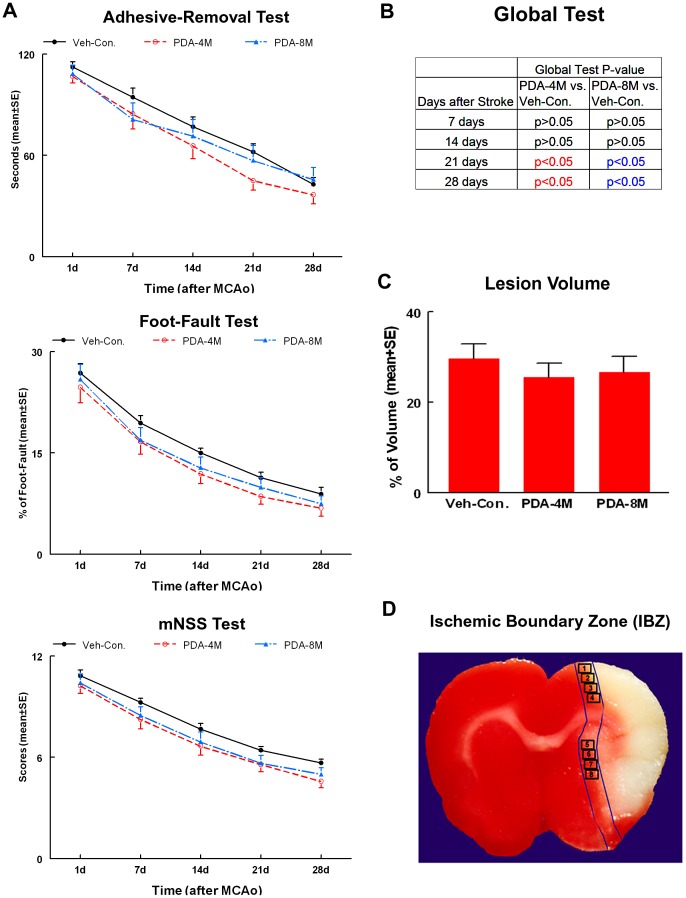
Neurological outcome and lesion volume in older rats.Panel A shows adhesive-removal, foot-fault and mNSS tests after stroke in the 3 older rats experimental groups (vehicle-control, 4×106 and 8×106 PDA-001 treatment groups). Panel B shows the global test analysis to detect the differences in functional recovery among the 3 groups. Panel C shows the lesion volume in the 3 older rats experimental groups. Panel D shows the ischemic boundary zone (IBZ). Error bars represent standard error of the mean (mean±SE).